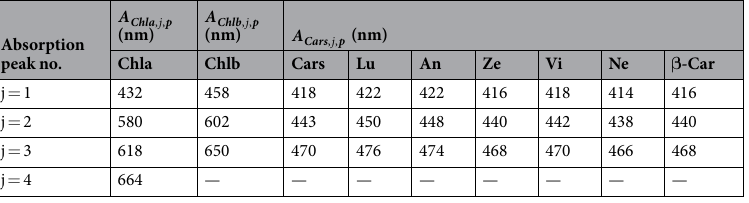
Extension of PROSPECT to PROSPECT-MP for multiple pigment retrieval . In the PROSPECT model, leaf ) and DHT ( T ) are given 11 by: DHR ( R N N T R T T T − − 1st 1 N N 1st 1 = + = R R T ; N 1st − − R R R R 1 1 (5) N − − N N 1 1 where R and T , R and T , and − R and − T are the DHR and DHT of the first layer, the internal elementary st 1 st 1 N 1 N 1 layer and the internal N -1elementaayers. They can be parameterized by parameters N and m mission coefficient). The paramter τ . is related to λ k ( ) through the following equation 36 : − ∞ − − k e k x e dx (1 ( )) ( ) k x ( ) 2 1 ∫ τ λ λ = − + λ λ k ( ) With k derived as in equation 2, incorporating the absorption coefficients of multiple individual photosynthetic pigments in vivo , we use the improved k in equation 2 to replace k of PROSPECT model in equation 6 to extend the model at 400–800 nm to a leaf optical model (PROSPECT-MP) for the simultaneous retrieval of multiple individual photosynthetic pigments (Chla, Chlb and Cars). In addition, the methods of calibration and evaluation for PROSPECT-MP and PROSPECT-5 in the LOPEX93 dataset were shown in the Note S1 and S2 of ‘Supplementary Information’.